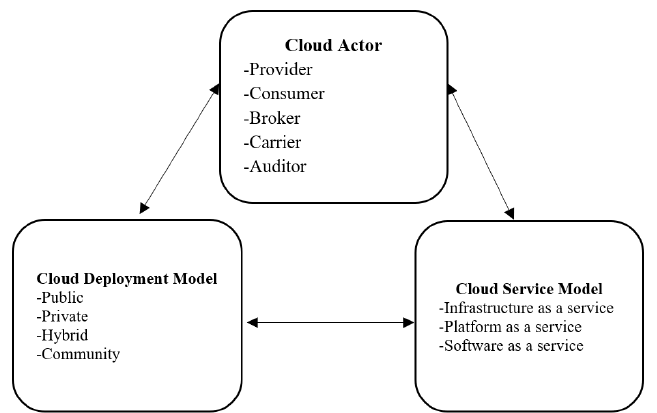
Figure 5. Three-dimensional approach of NCC-SRA from NIST Cloud Computing Security Reference Architecture